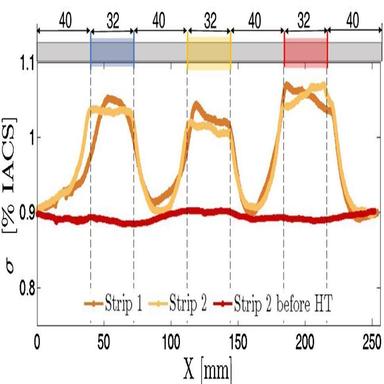
Electrical conductivity profile of FGM using eddy current testing at room temperature.